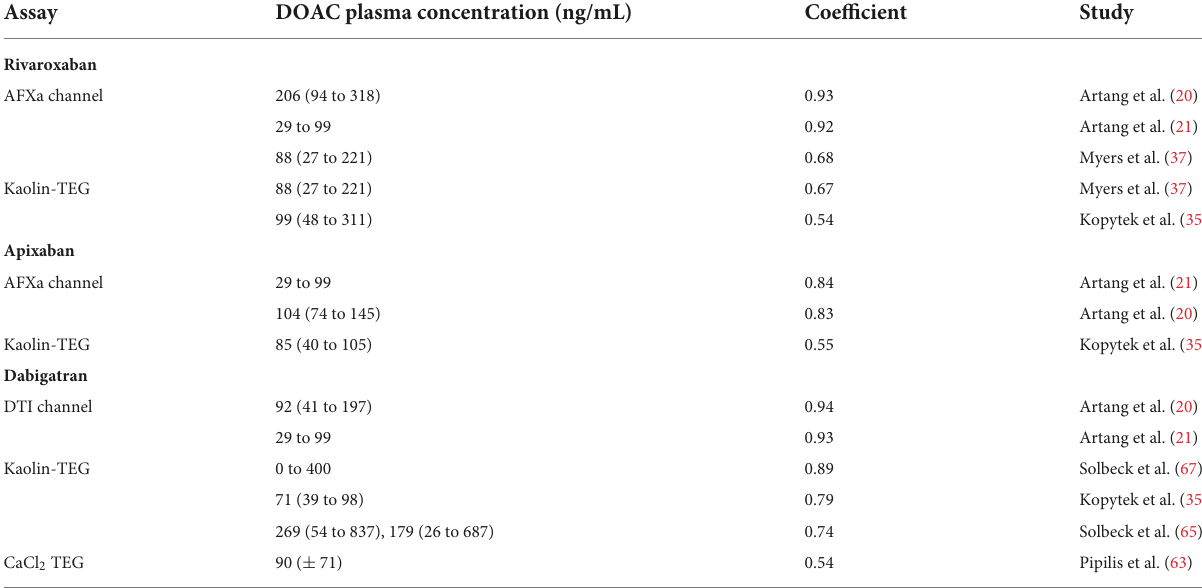
TABLE 2.2 Correlation of DOAC plasma concentration and TEG reaction time (R) for different assays.